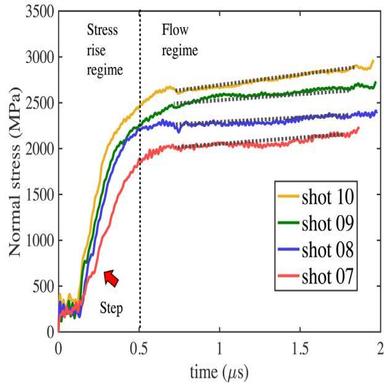
Normal stress history for all PSPI shots. Note that in order to compare stress or strain rate history profiles of different shots, all curves are shifted relative to their first wave arrival times. (For interpretation of the references to color in this figure legend, the reader is referred to the web version of this article.)